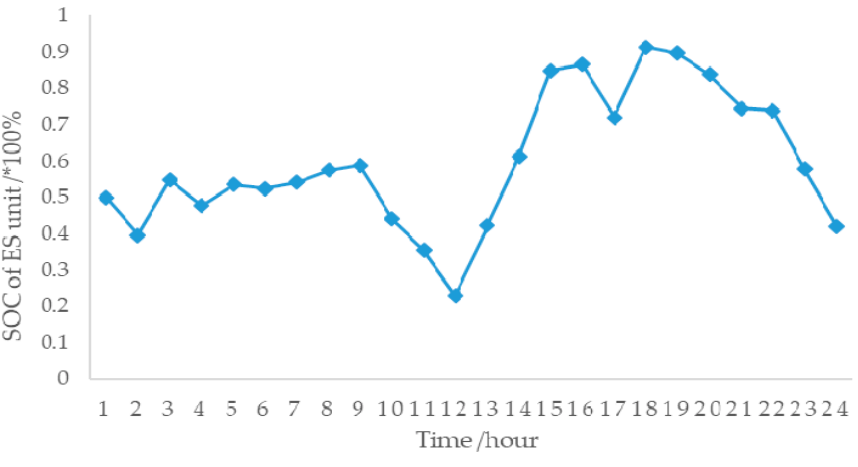
Figure 10. SOC of ES in one cycle.